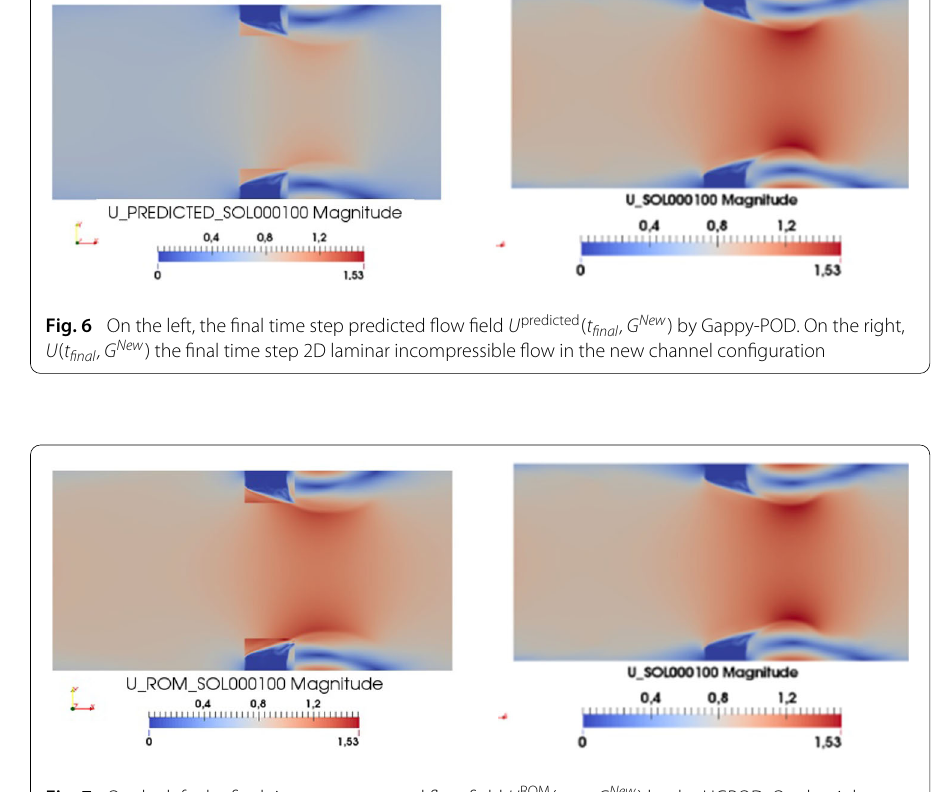
Application of the